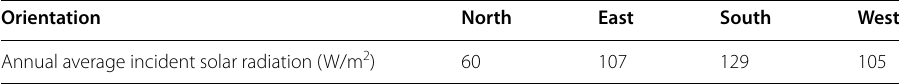
Table 8 Solar radiation in different orientations Orientation